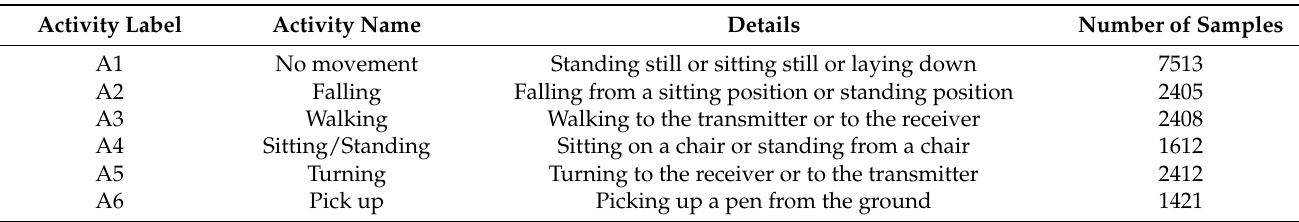
Table 1. Summary of Multi-environment dataset.